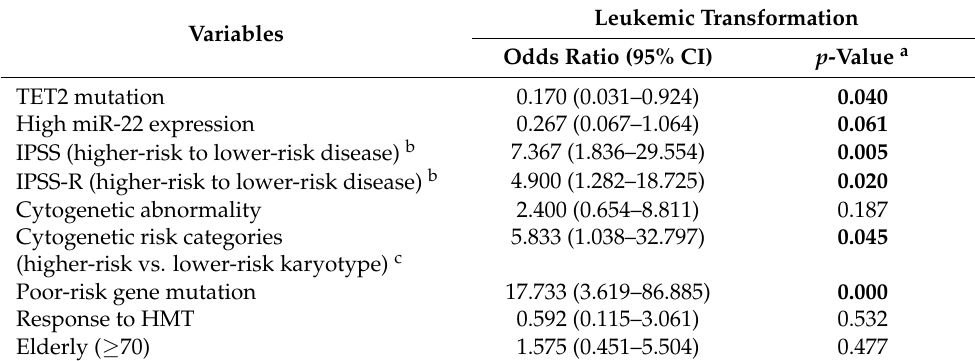
Table 6. Association of various clinical factors with leukemic